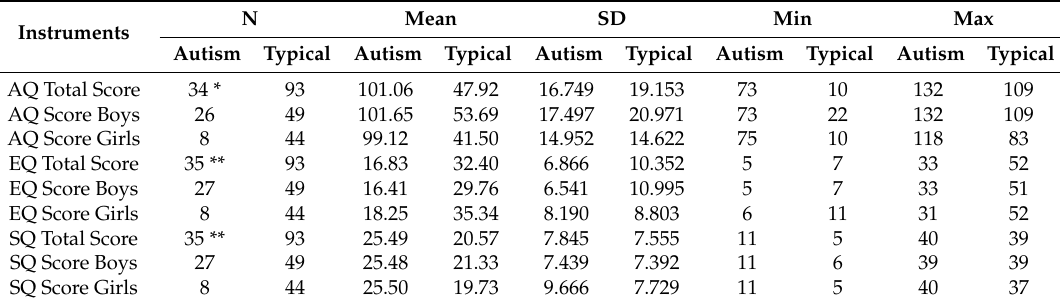
Table 1. Descriptive statistics AQ Child_NL, EQ Child_NL and SQ